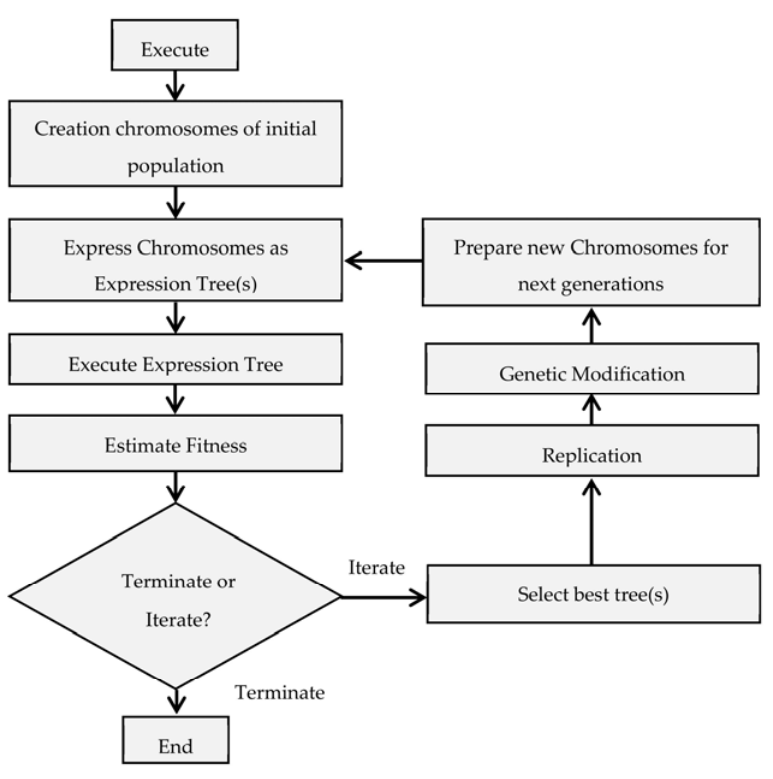
Figure 4. Flowchart demonstrating the model selection in gene expression programming.